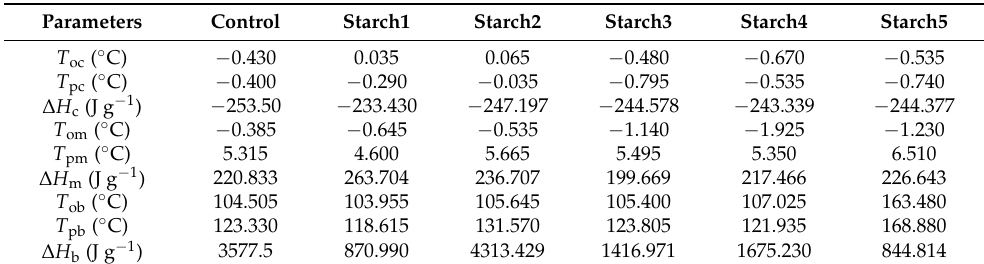
Table 3. Thermal properties derived from the DSC data for various milk samples [40]. Reprinted